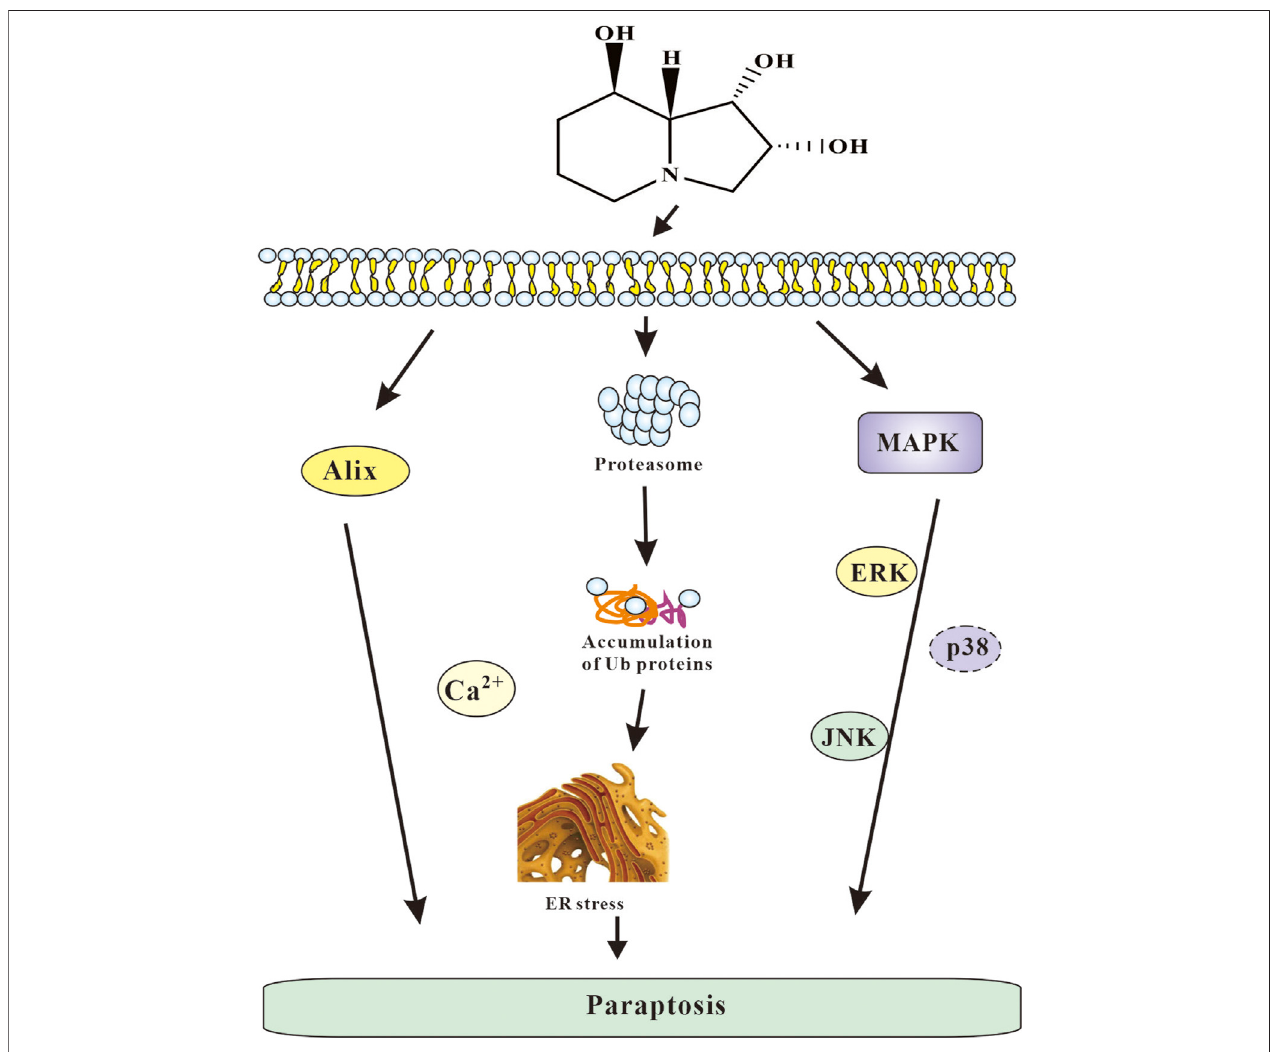
FIGURE 11 | The overall mechanism of SW induced cell